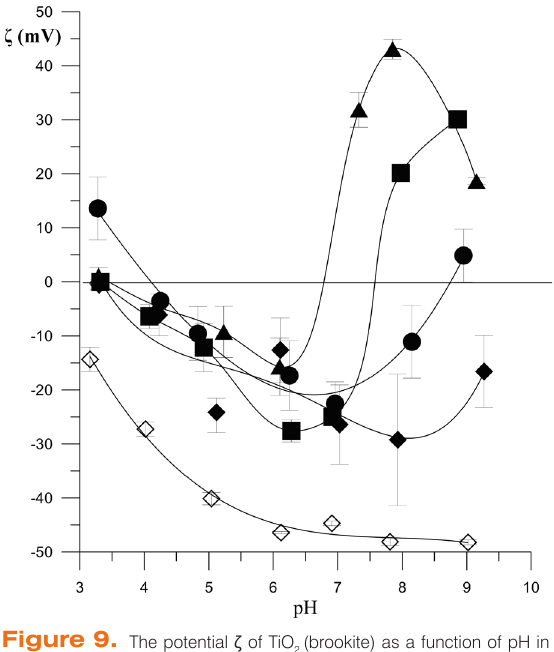
Figure 9. The potential ζ of TiO (brookite) as a function of pH in 2 the presence of Zn(II) ions. Zn (II) ions concentration: